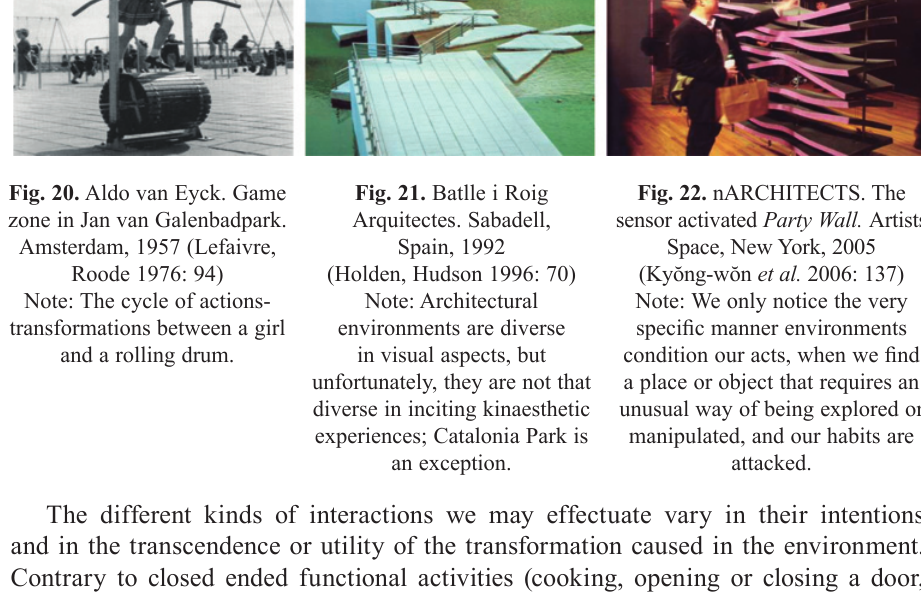
Fig. 20. Aldo van Eyck. Game Fig. 21. Batlle i Roig